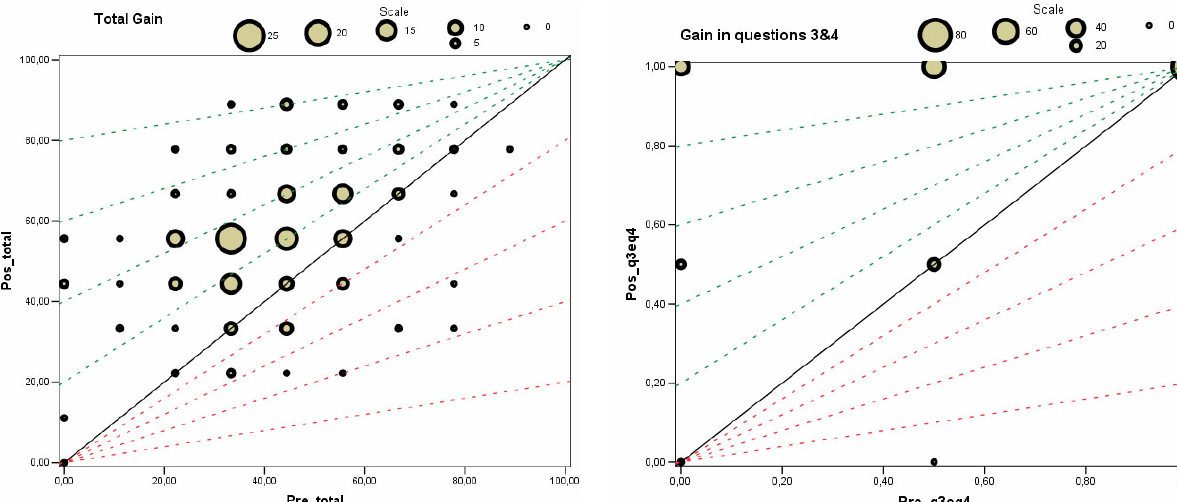
Figure 7. Gain results in the total questionnaire